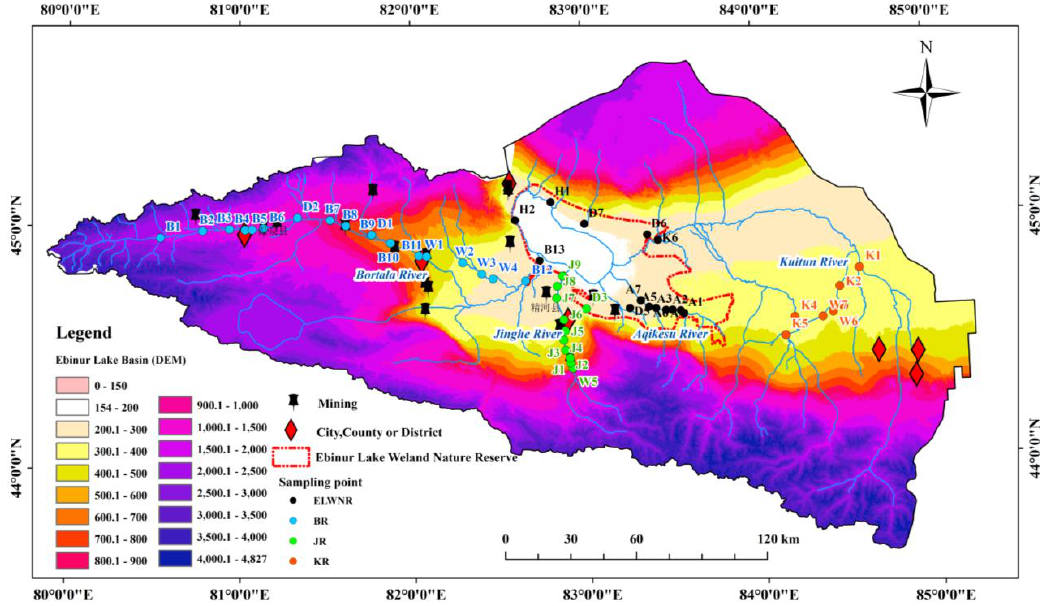
Figure 3. Point diagram (four areas: Bortala River (BR), Ebinur Lake Wetland Nature Reserve (ELWNR), Jing River (JR), and Kuitun River (K)).